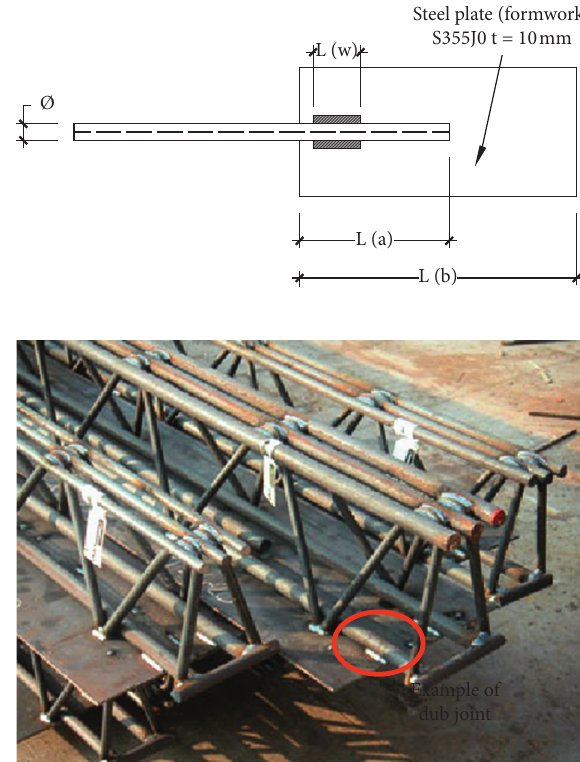
Figure 3: Double-sided lap joint between the steel plate and the